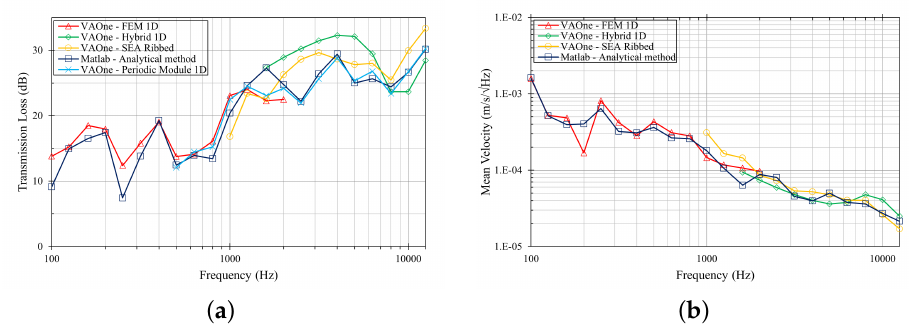
Figure 14. Vibro-acoustic responses of a panel with Z stiffeners (1D stringers): ( a ) sound transmission loss and ( b ) space-average mean vibration velocity.